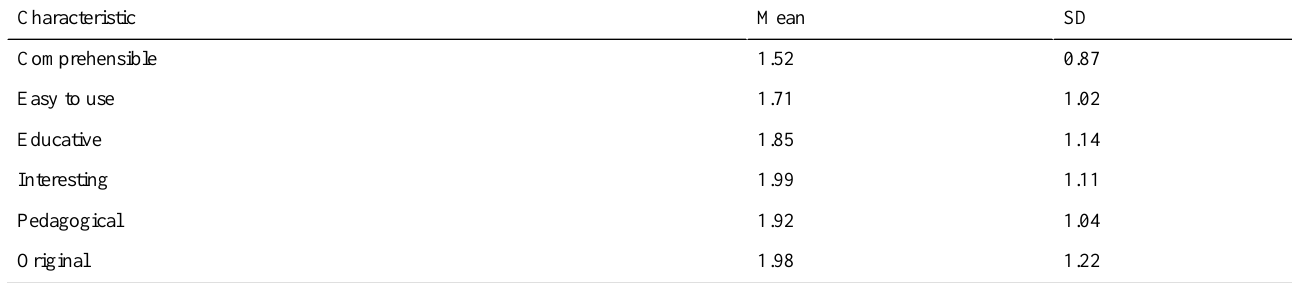
Table 5. Students’evaluation of “Erietta” simulation overall, on a scale of 1 (extremely) to 5 (not at all) (n=52).